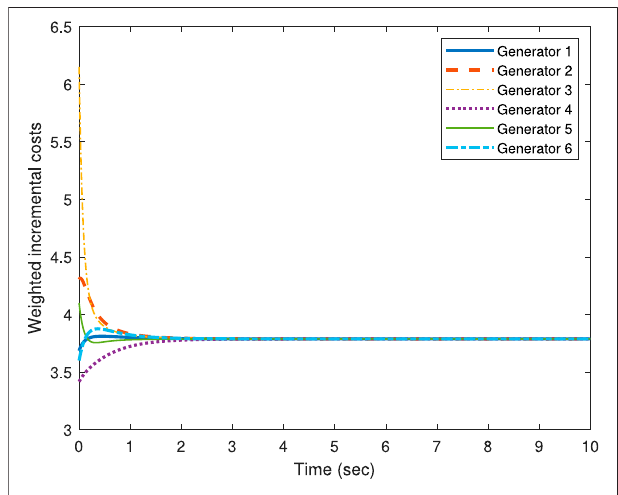
FIGURE5| WeightedICsofindividualgeneratorsversustime(sec)using the proposed approach ( via weight selection), w 1 = 1.1, w 2 = w 3 = w 4 = w 5 = 1.025 and w 6 =